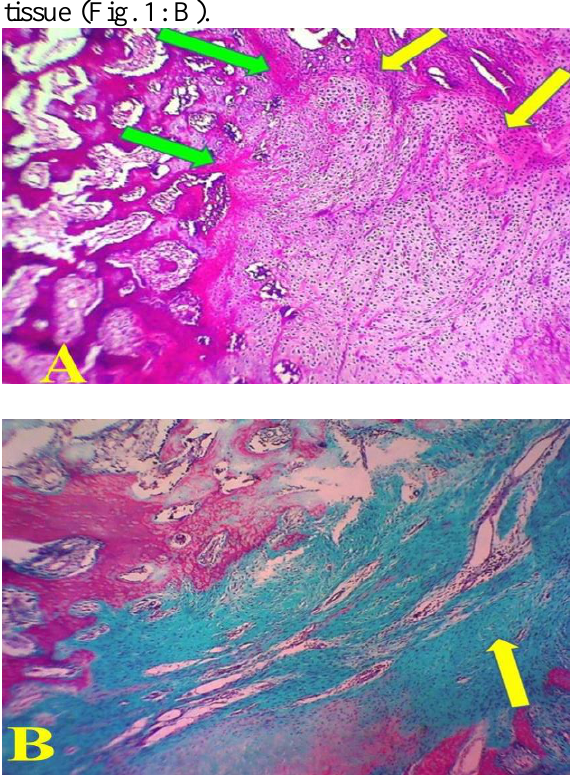
Figure, 1: Histopathological section of radial bone after inducing distal radial fracture, in the first group at the sixth week, shown fibrous tissue (yellow arrow) in the fracture gap, with fibrocartilaginous tissue (green arrow). A: H&E X40, B: Masson trichrom X40.